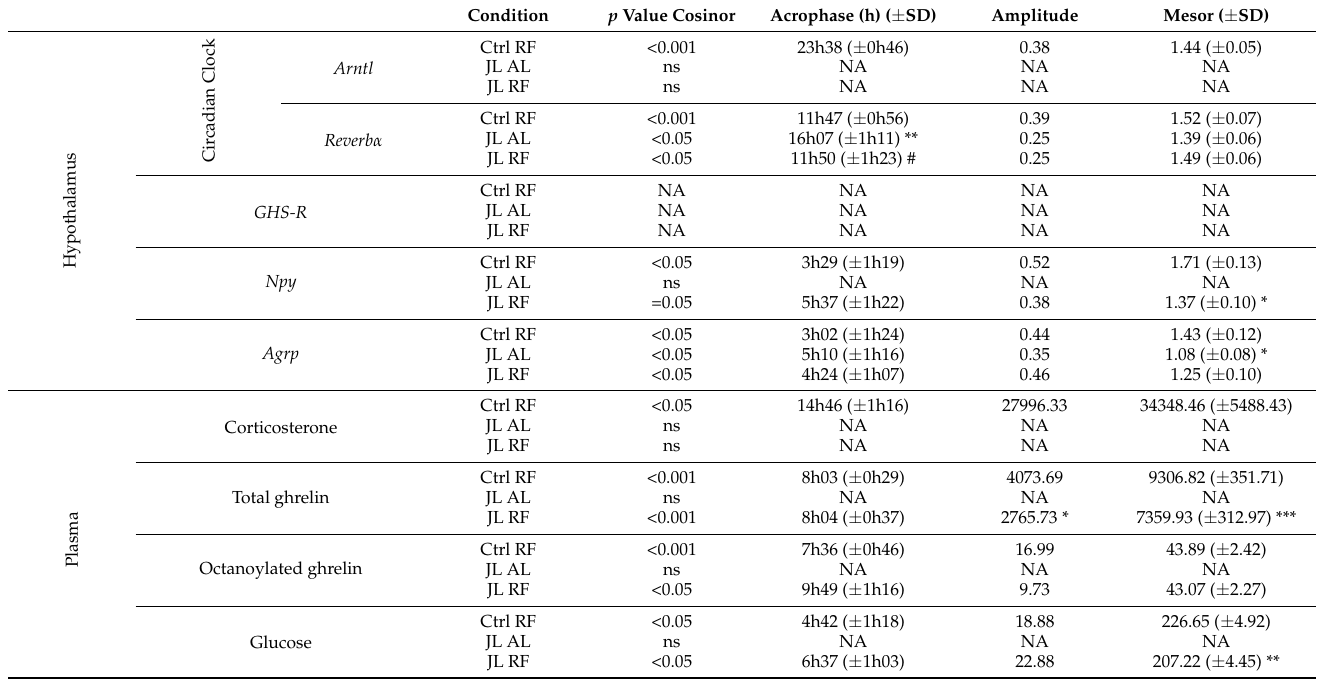
Figure 2. Effect of time restricted feeding on hypothalamic clock gene mRNA expression and plasma corticosterone levels. ( A ) Arntl and ( B ) Reverb α mRNA expression in the mouse hypothalamus ( n =8mice per time point per group) of control mice fed a TRF diet (Ctrl RF), jetlagged mice fed ad libitum (JL AL) and jetlagged mice fed a TRF diet (JL RF). ( C ) Plasma corticosterone levels ( n = 4 mice per time point per group). The fitted cosine curve determined by cosinor analysis (period = 24 h) are shown in Ctrl RF, JL AL and JL RF mice. The dark phase is shaded grey. Statistics: Non-linear regression (Proc NLIN). ns = not significant. p values refer to probability values for the best fitting cosine curve. Table 2. Cosinor values of all measured